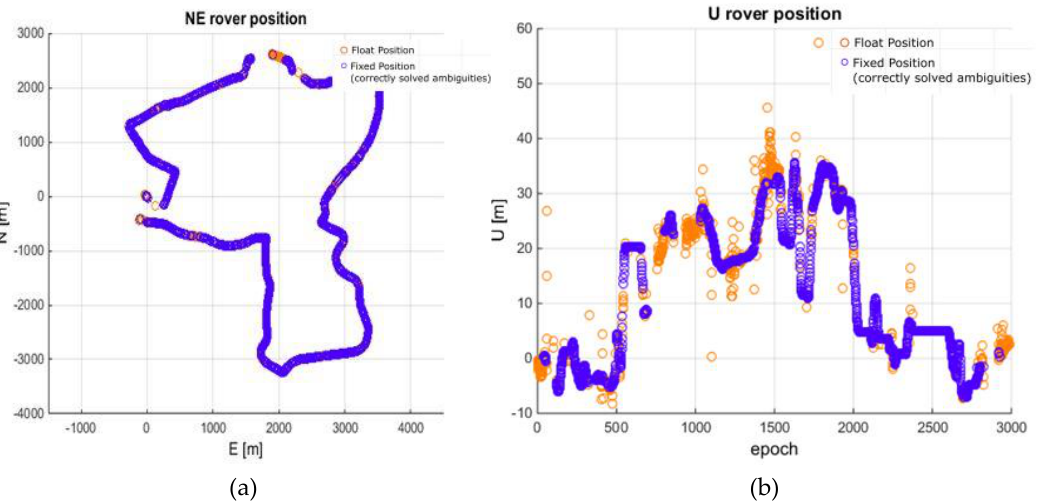
Figure 8. Reference rover trajectory derived from processing short baseline (KRO1). ( a ) Horizontal components; ( b ) Vertical components.